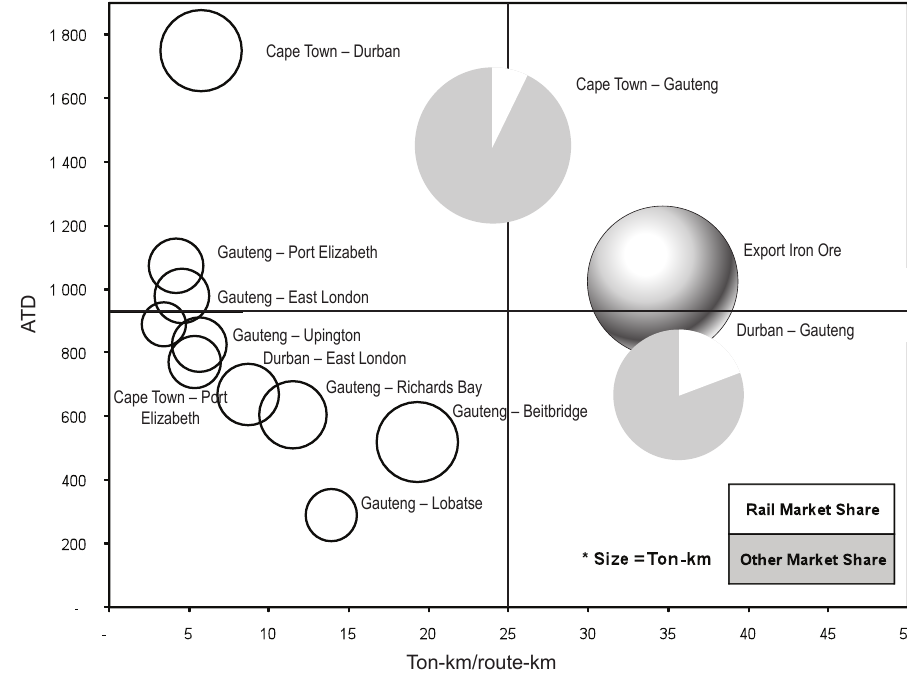
Figure 2: Market segmentation – potential corridor density (data source: FDM, 2009)